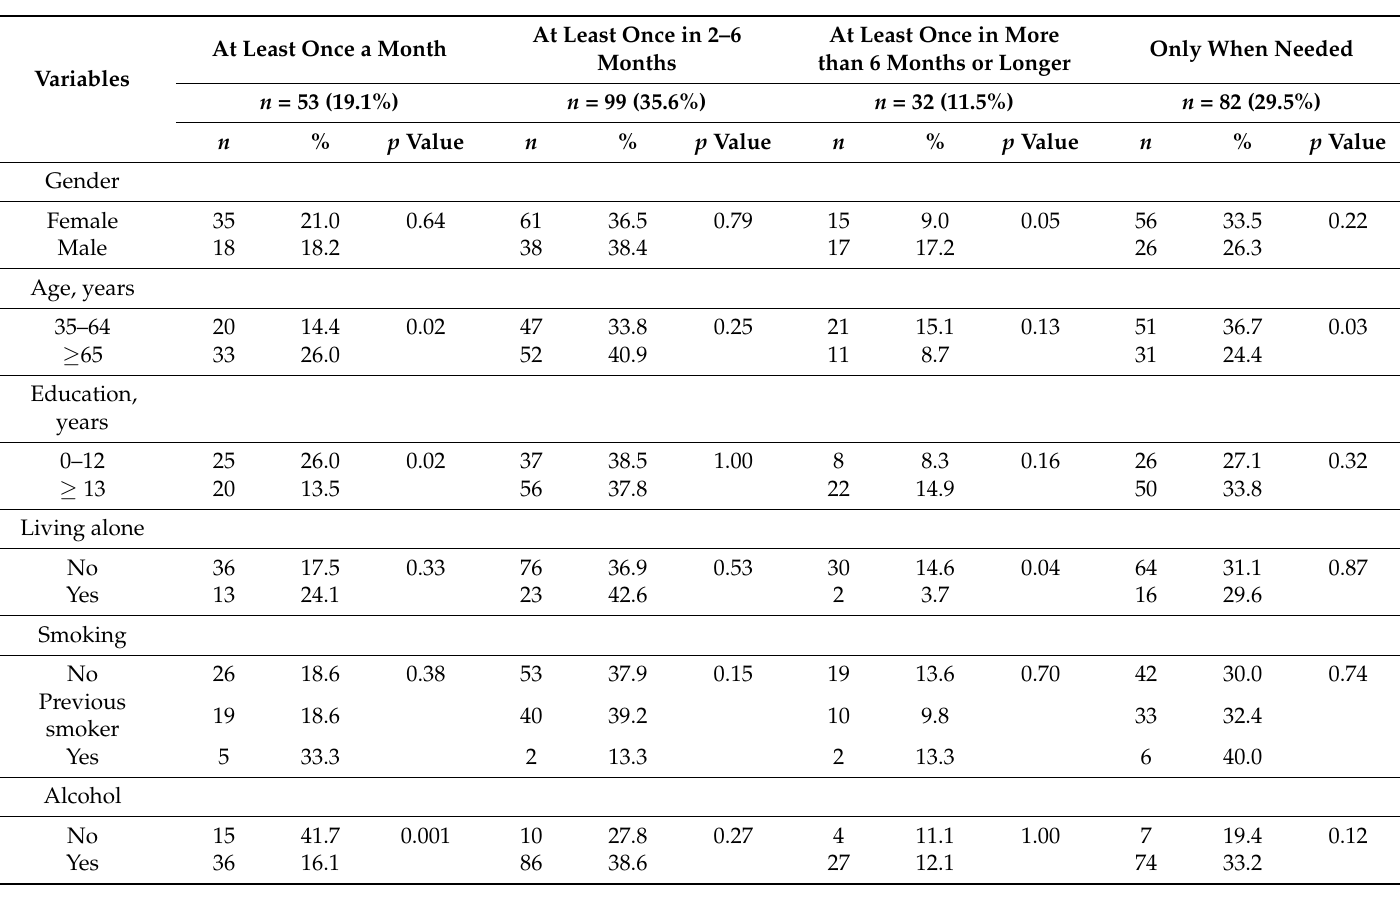
Table 3. Distribution of sociodemographic characteristics, clinical risk factors, BP knowledge, BP perception and SRH across the categories of GP visit